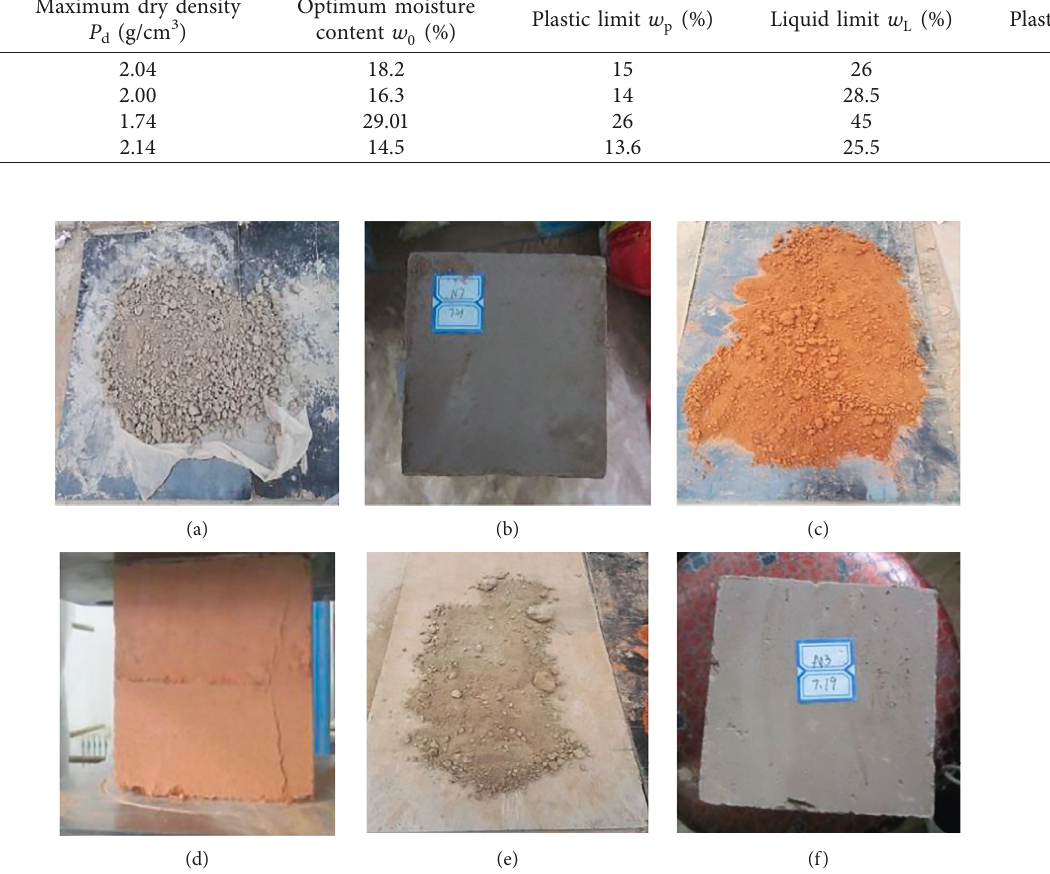
Figure 2: Raw materials and samples of black, red, and sand earths. (a) Raw black soil material. (b) Specimen. (c) Raw clay material. (d) Specimen. (e) The raw material of sand soil. (f)